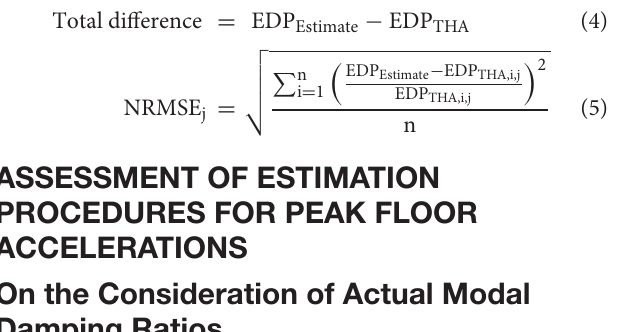
Frontiers in Built Environment |